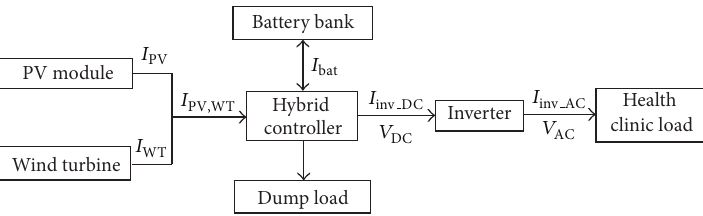
Figure 3: Configuration of the integrated renewable (PV/wind) energy system with the energy storage and dump load.